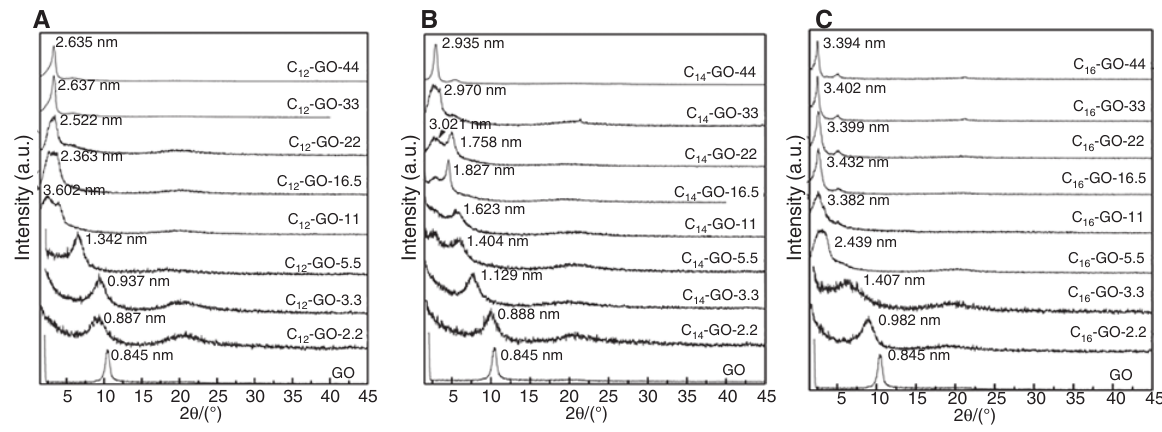
-GO- t (A), C -GO- t (B) and C 12 14